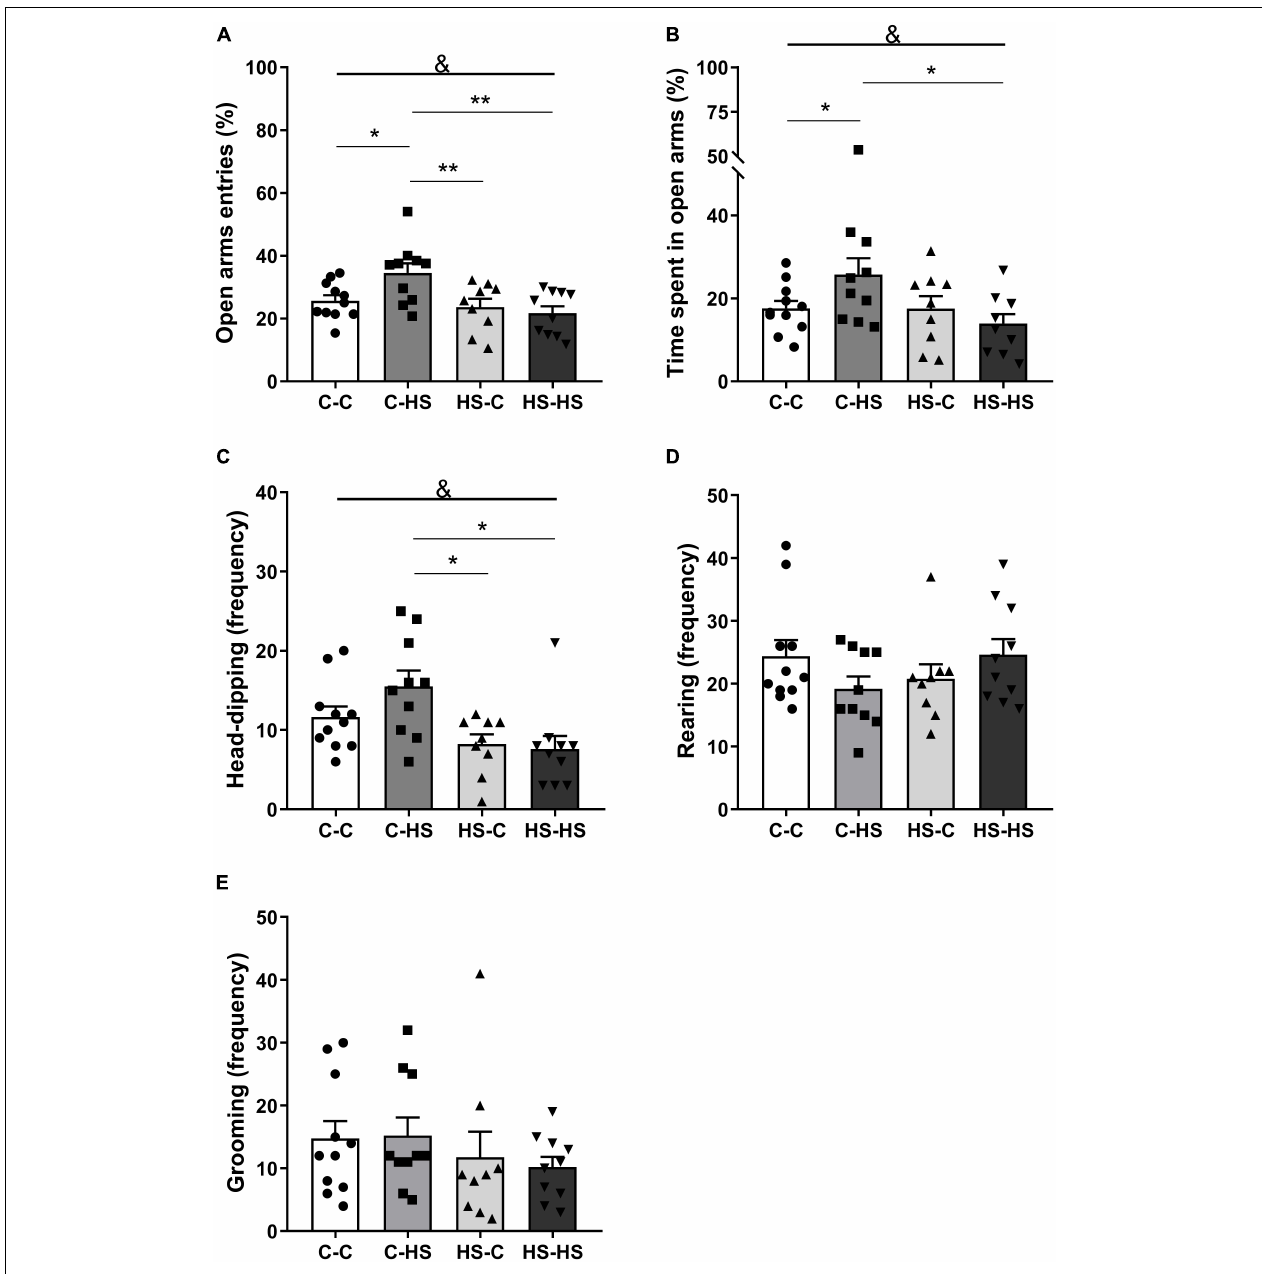
FIGURE 2 | Ratio of entries (A) and time spent in the open arms (B) ; head-dipping (C) , rearing (D) , and grooming (E) frequency in the elevated plus maze test. C-C, offspring of standard diet fed dams who received a standard diet after weaning; C-HS, offspring of standard diet fed dams who received a HS diet after weaning; HS-C, offspring of HS diet fed dams who received a standard diet after weaning; and HS-HS, offspring of HS diet fed dams who received a HS diet after weaning. Data are shown as mean and SEM; n = 9–11; & p < 0.05 (preweaning factor); * p < 0.05, ** p < 0.01 (interaction of the pre- and postweaning factors) using the ANOVA and the Newman–Keuls